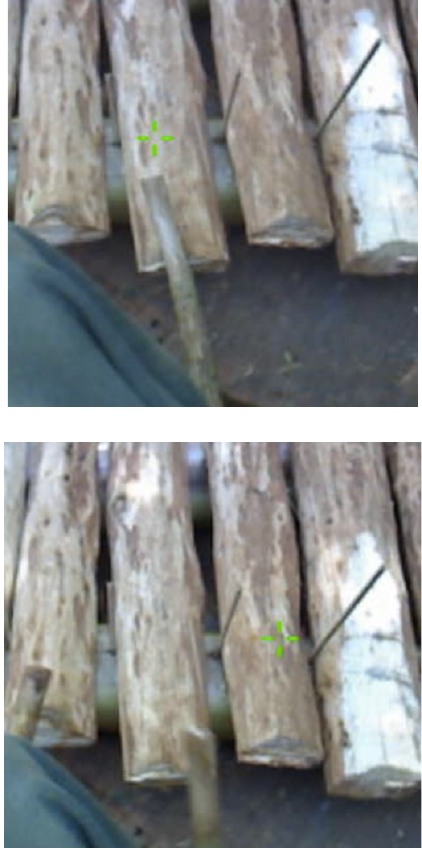
Figure 18. Two illustrations of the gaze-point on a